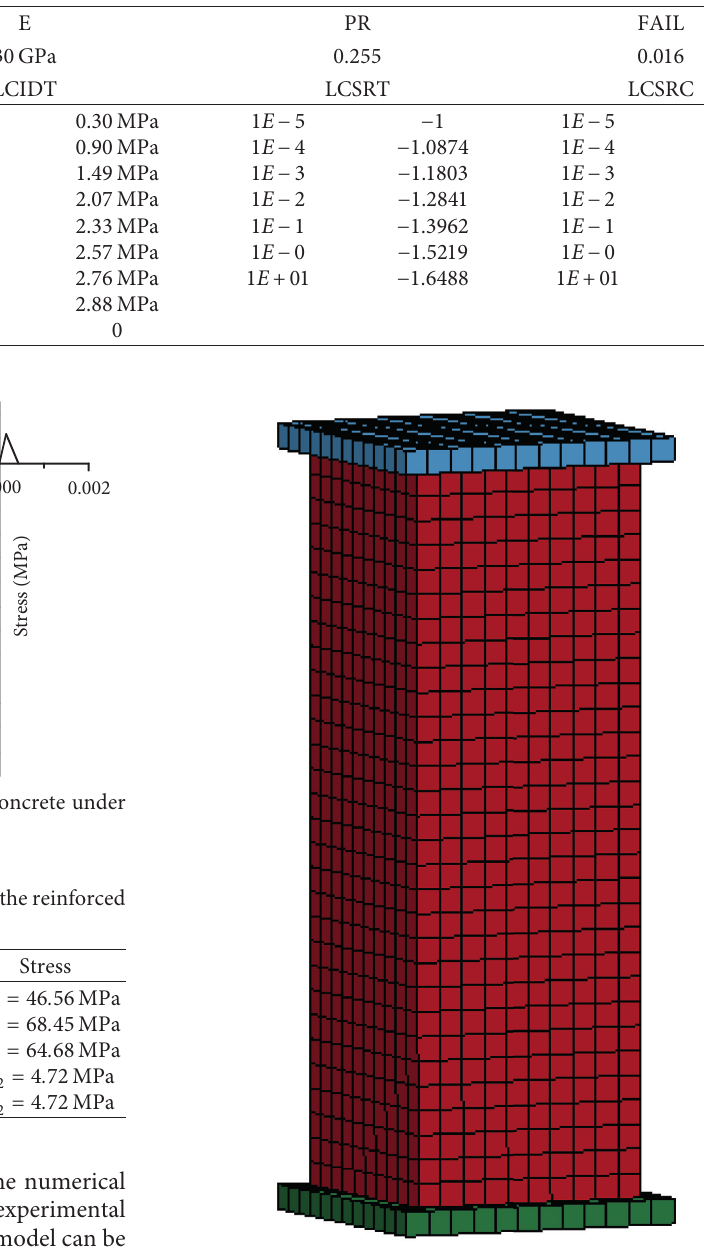
Table 1: The parameter values of the C30 standard cube element.